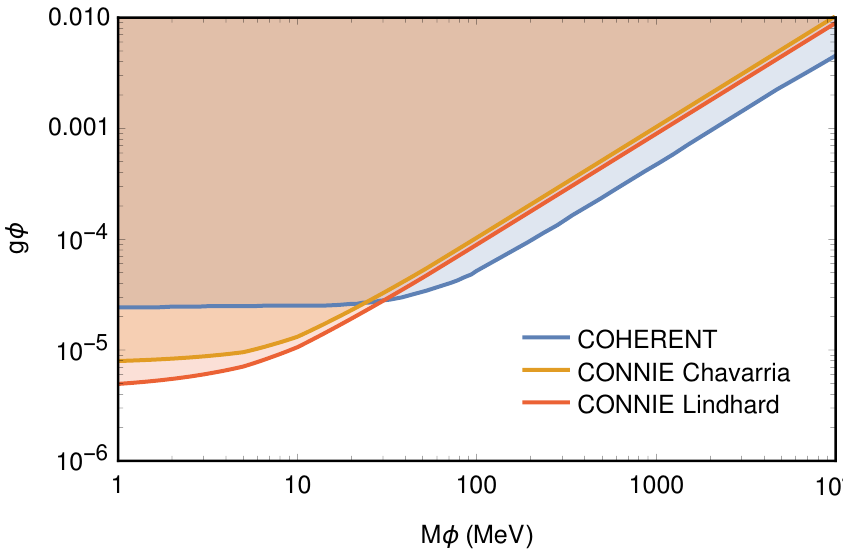
Figure 3 . Exclusion region in the ( M (cid:30) ; g (cid:30) ) plane from the CONNIE results assuming quenching given by the (cid:12)t to the measurements in ref. [33] (orange) and the expressions in ref. [34] (red). The 90% COHERENT limit curve in ref. [7] (blue) is shown for reference.